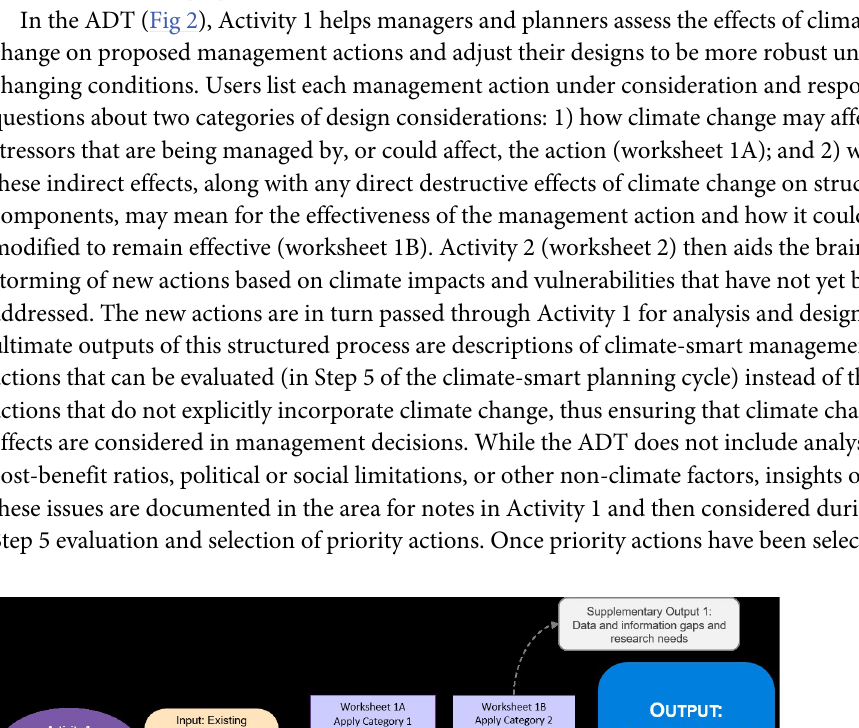
PLOS ONE | https://doi.org/10.1371/journal.pone.0253343 June 24,